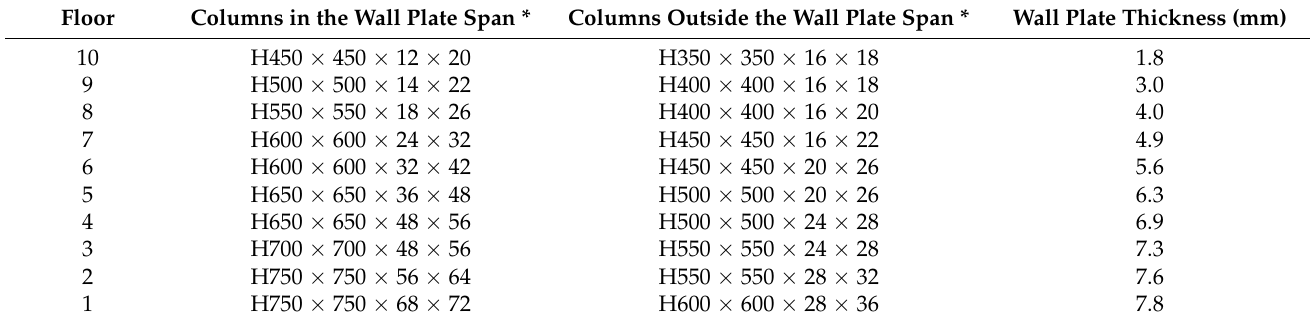
Table 11. Member Sections from of the structural